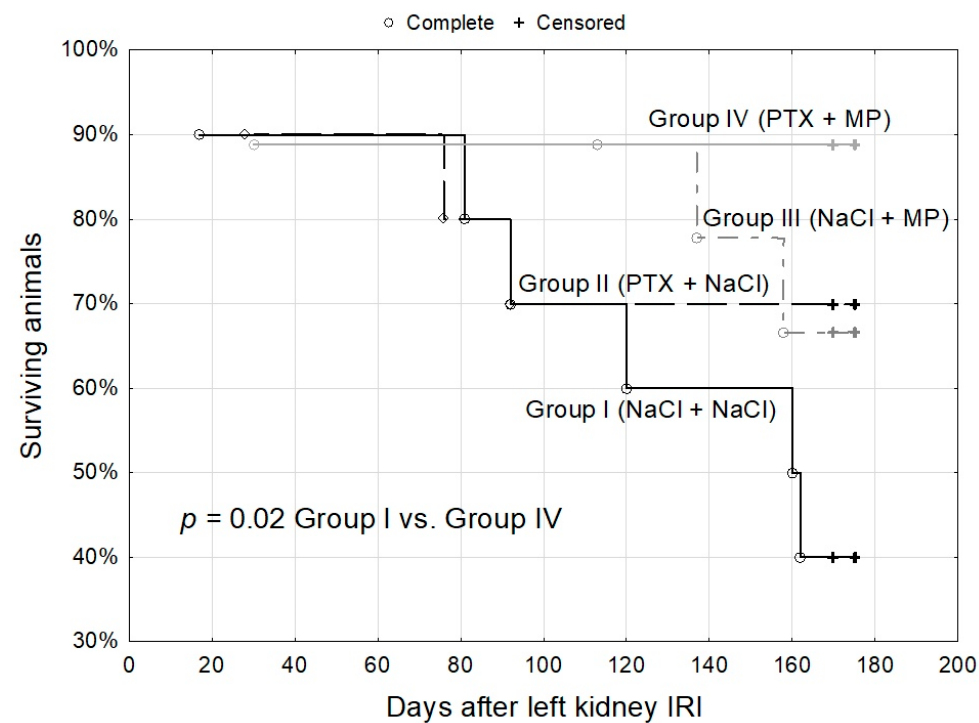
Figure 2. Chronic kidney disease model—survival of the animals in the 24-week observation after the prolonged ischemia of left kidney with subsequent excision of right kidney at 2 weeks after left kidney IRI: in the control rats administered saline infusions (Group I), rats administered PTX prior to IRI (Group II), those administered MP post IRI (Group III) and those infused with both PTX and MP around IRI (Group IV). Kaplan-Meier curves; log-rank test.